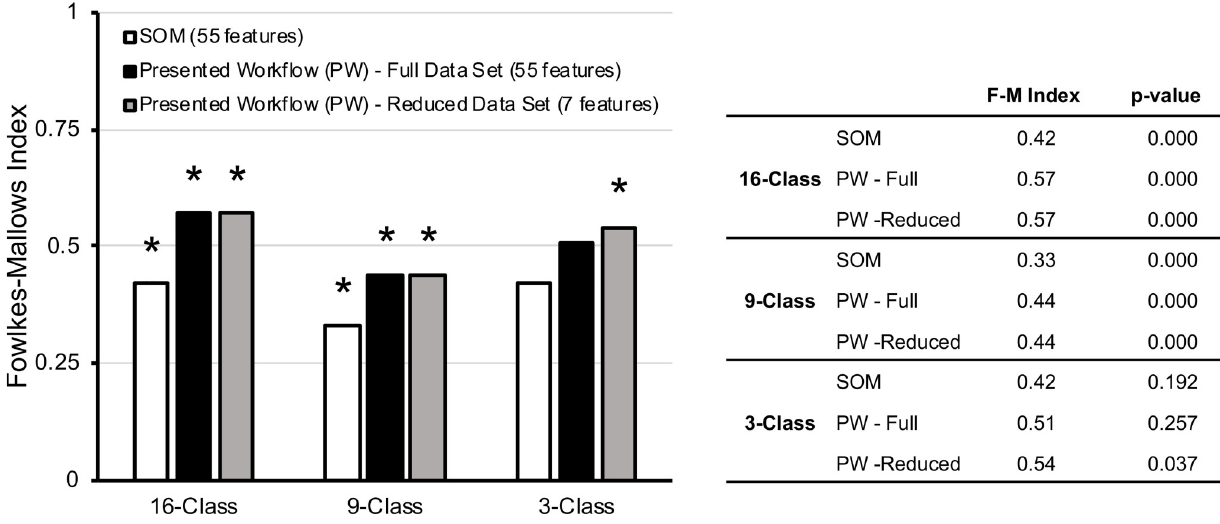
Fig 4. Fowlkes-Mallows index for the outcomes of clustering of SRM samples. � indicates that the results are statistically significant at the 0.05 level.